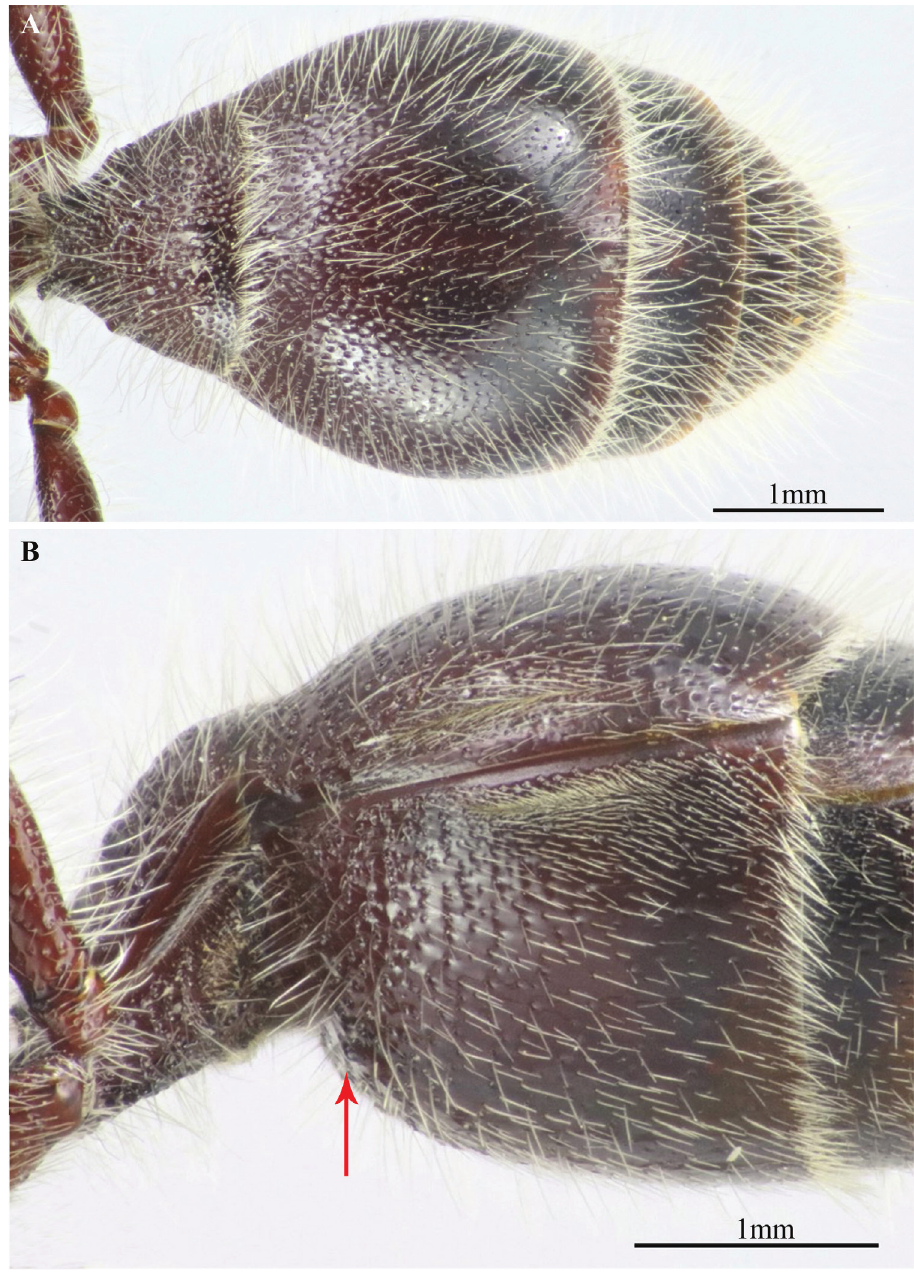
Figure 25. Pseudophotopsis maura Bischoff (Male) A metasoma, dorsal view B 1 st and 2 nd metasomal segments latero-ventral view (median basal tubercle on S2